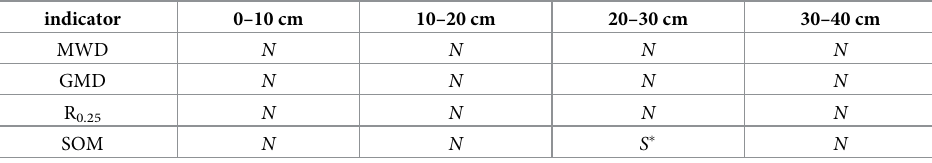
Table 5. Effects of straw residue and tillage interaction on WSAs and SOM at different soil depths. indicator GMD N N N N R 0.25 N N N N SOM N N S � N Note: N indicates no significant effect ( P > 0.05, double tailed test); S � indicates significant effect ( P < 0.05, double tailed test).